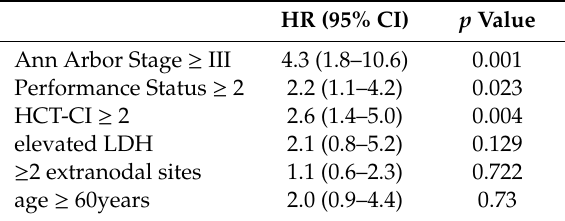
Table 5. Prognostic factors for overall survival in multivariate analyses using the